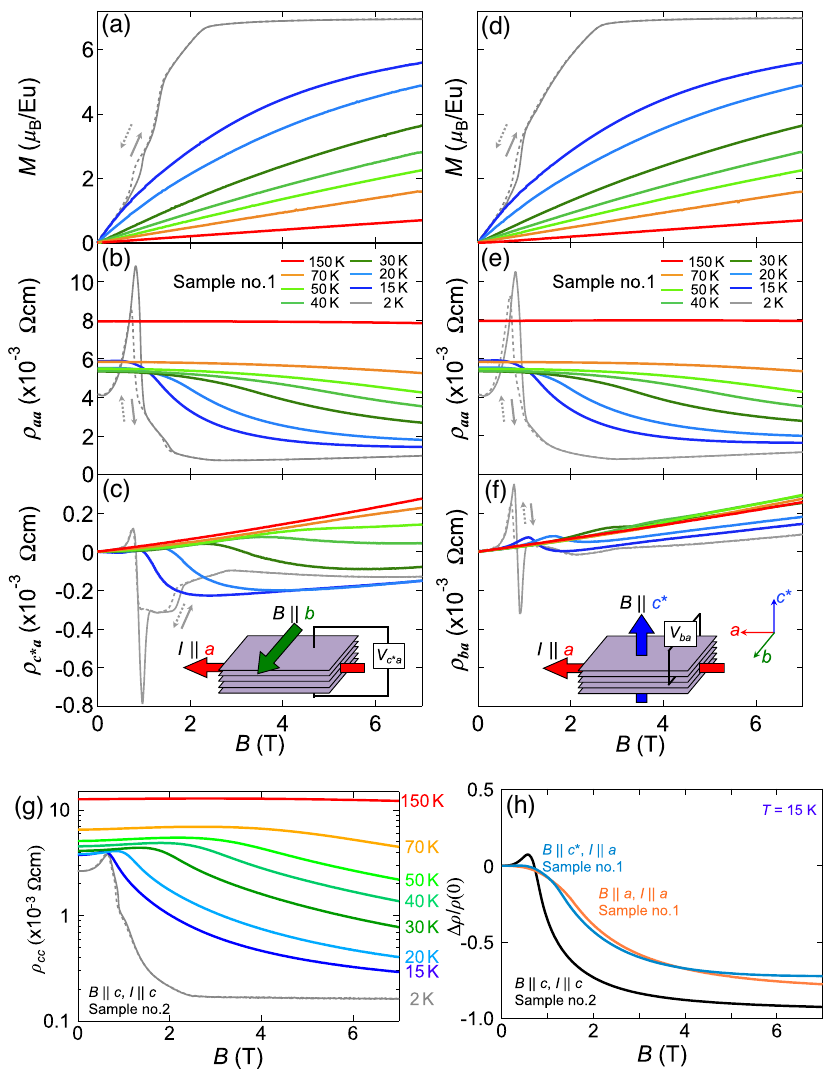
FIG. 2. Magnetic and transport properties of α -EuP 3 . Magnetization, longitudinal resistivity, and Hall resistivity as functions of B along the b axis (a – c) and c (cid:2) axis (d – f). The insets show the schematics of the measurement configuration. (g) ρ cc measured with